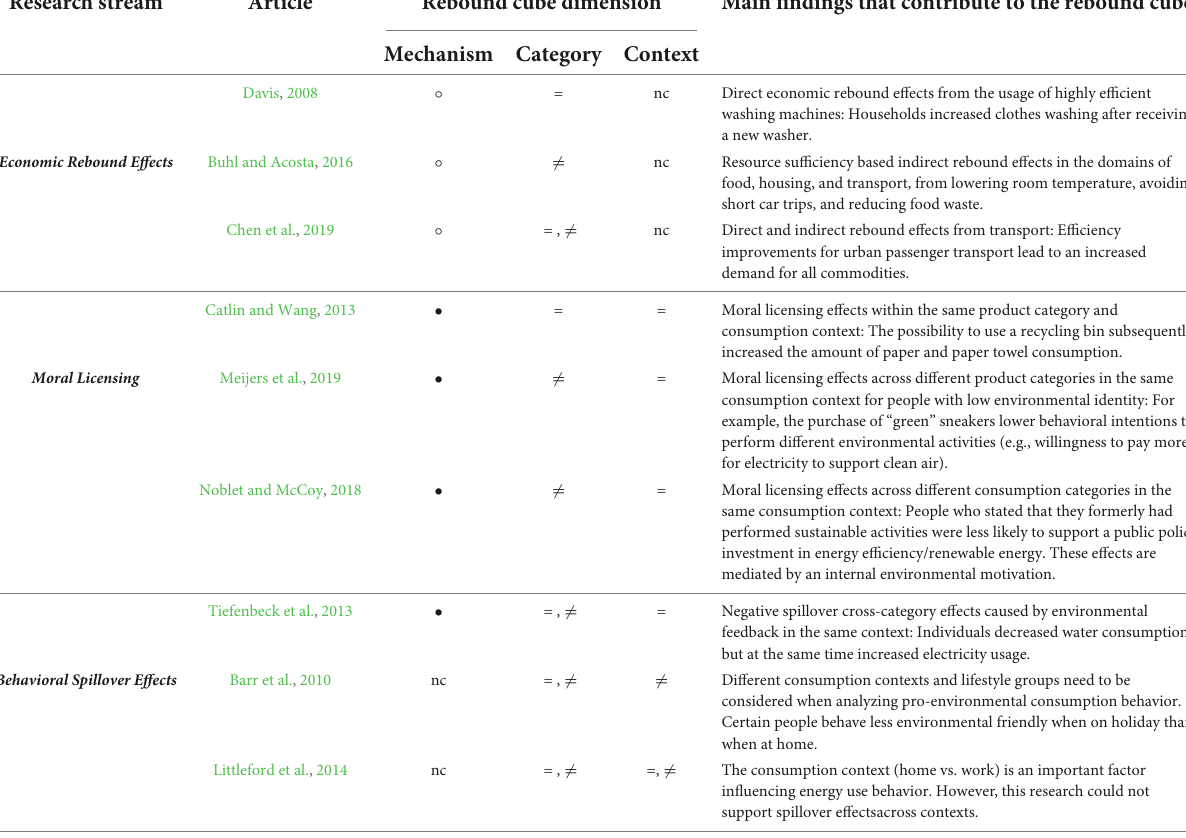
TABLE 1 Overview of recent research that contributes to rebound